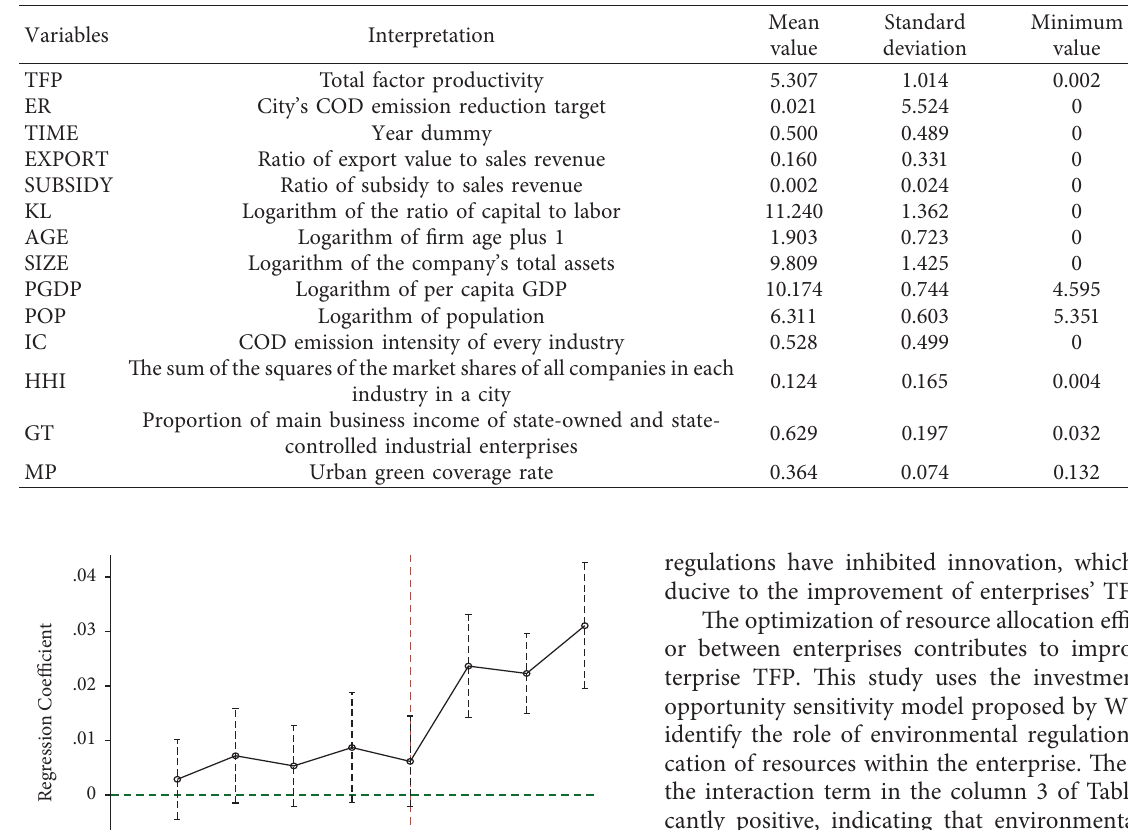
Table 1: Descriptive statistics.